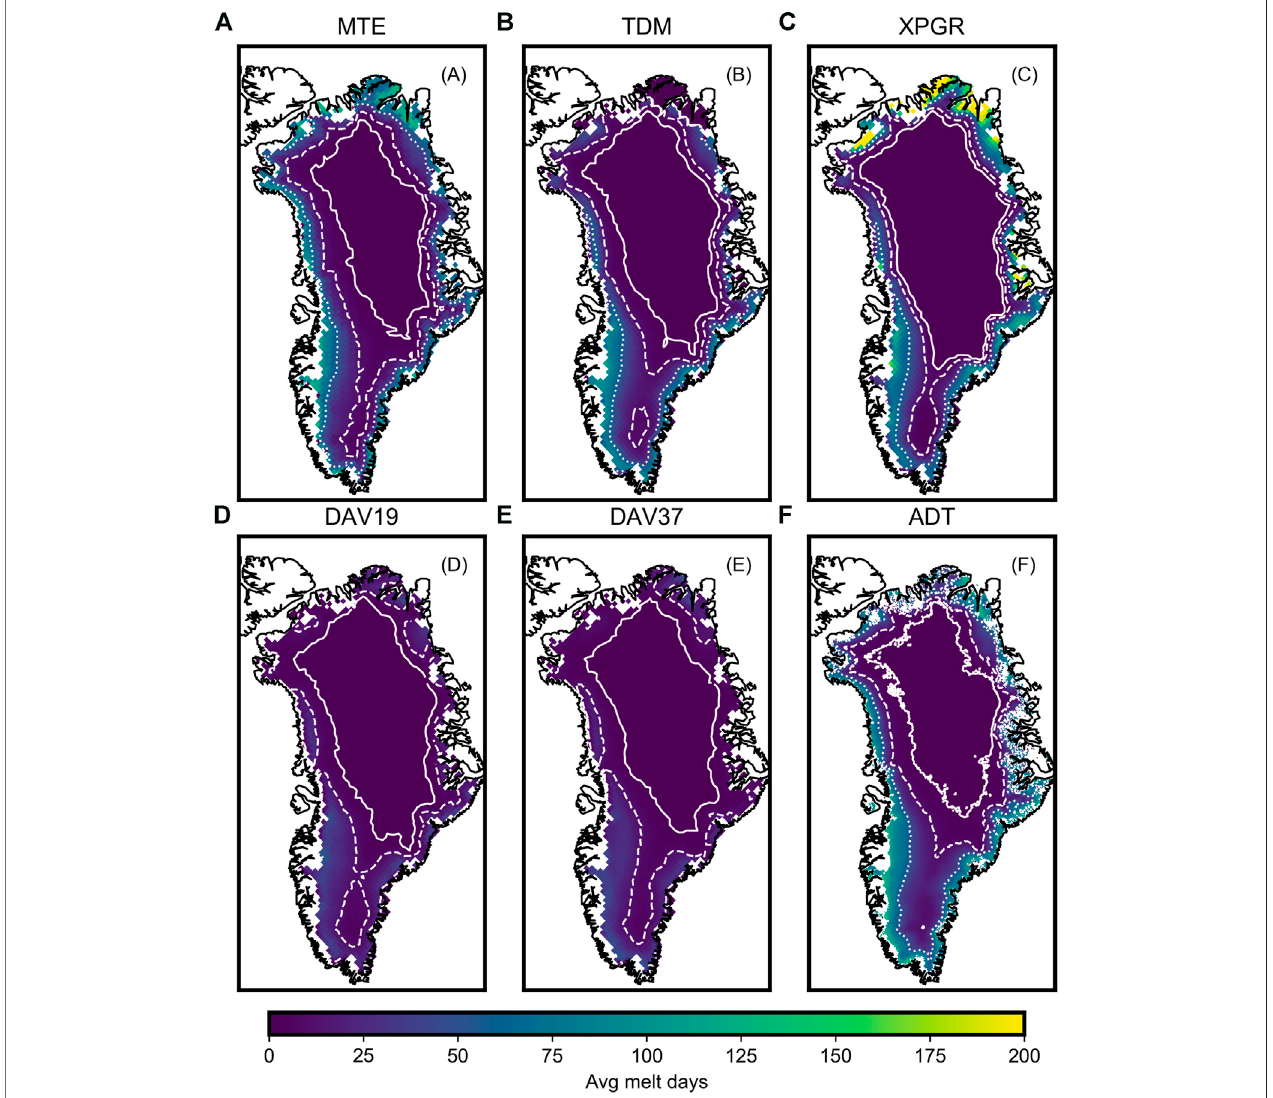
FIGURE 5 | 2003-2007 average melt days over the GrIS from six microwave melt products including MTE (A) , TDM (B) , XPGR (C) , DAV19 (D) , DAV37 (E) , and ADT (F) . Solid white line is the 1-melt day contour, dashed line is the 10-day contour, and dotted line is the 50-day contour.